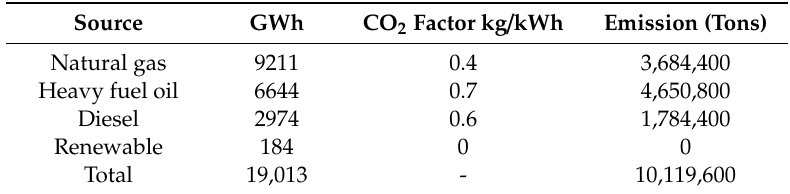
Table 4. Electrical energy production shares from di ff erent sources including renewable energy resources in Jordan